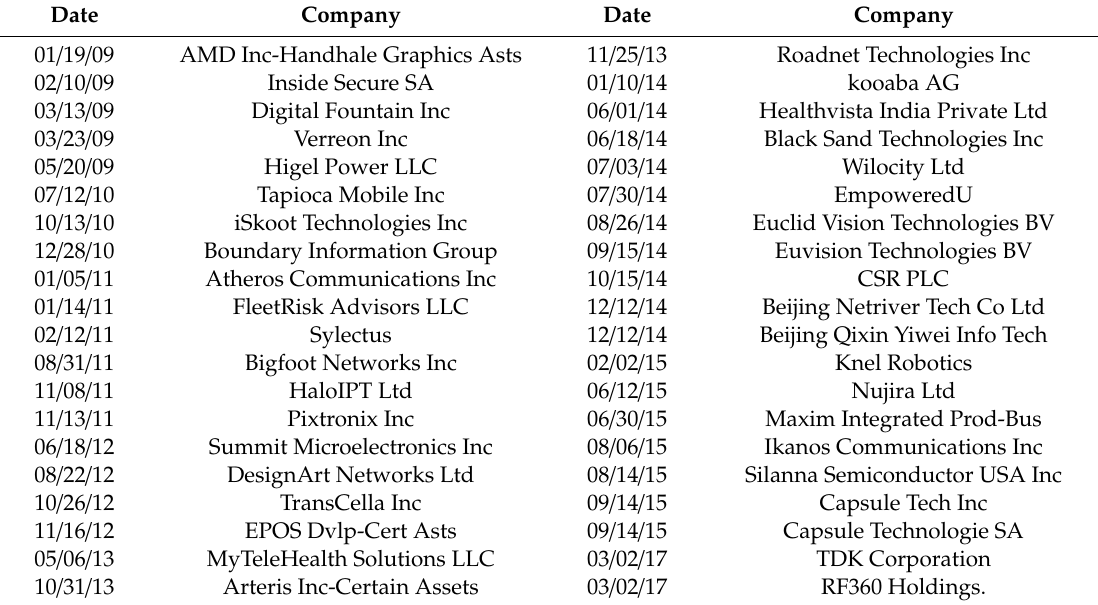
Table 6. Qualcomm’s M&A (Merger and Acquisition)